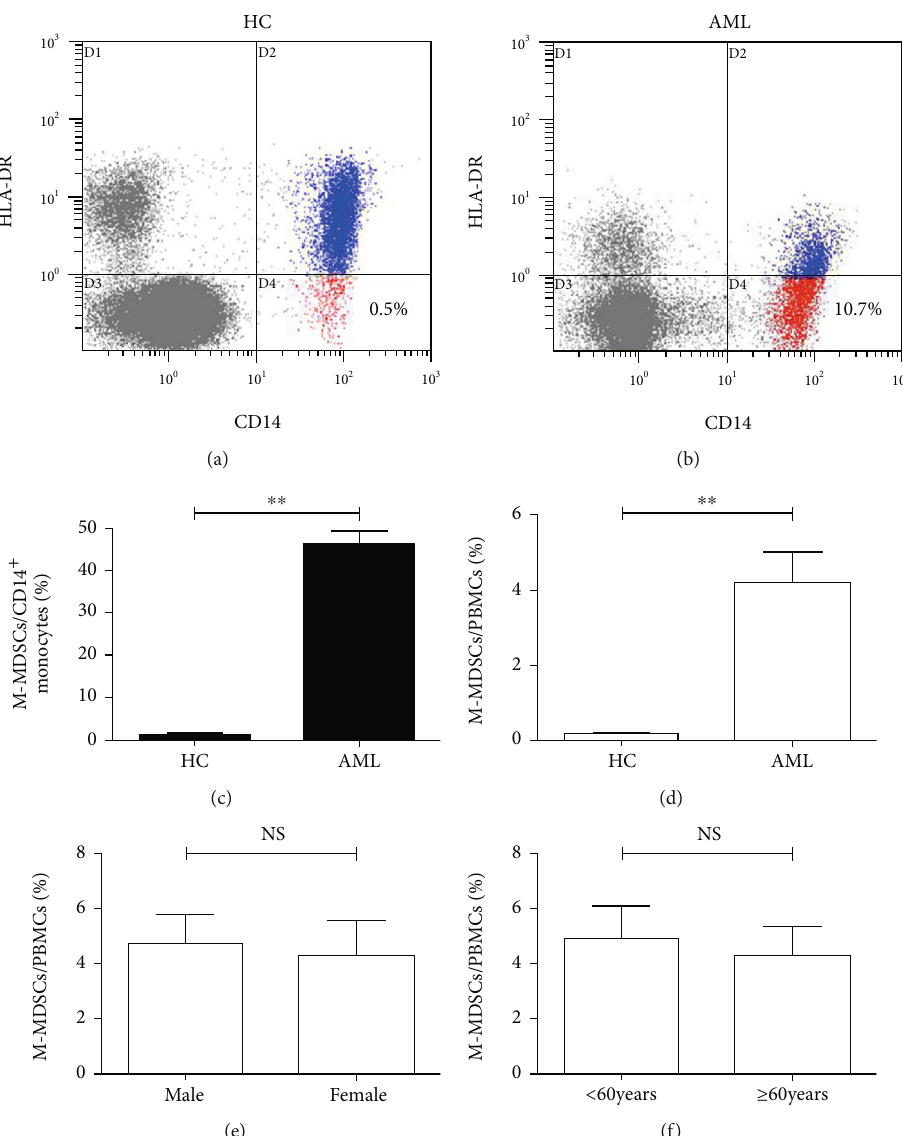
Figure 1: The frequencies of circulating M-MDSCs were elevated in AML. Representative fl ow cytometry dot plots demonstrated the frequencies of CD14 + HLA-DR LOW/- M-MDSCs in AML (a) and HC (b). The frequencies of circulating M-MDSCs of AML ( n = 109 ) and HC ( n = 30 ) in the percentage of CD14 + monocytes (c) and PBMCs (d). The frequencies of circulating M-MDSCs of AML in di ff erent gender groups (e) and age groups (f). AML: acute myeloid leukemia; HC: healthy controls; NS: not signi fi cant; ∗∗ p < 0 : 01